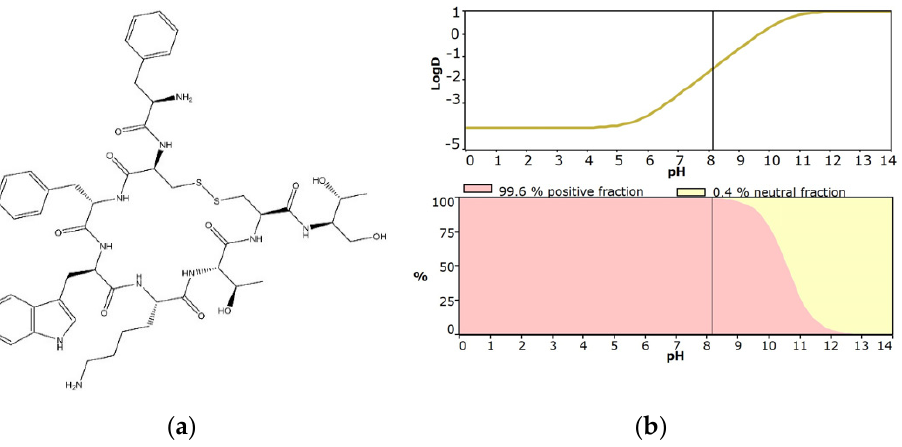
Figure 1. (a) Octreotide chemical structure; (b) plots of the LogD values (top) and the ionization Figure 1. ( a ) Octreotide chemical structure; ( b ) plots of the LogD values (top) and the ionization fraction (bottom) as a function of pH. fraction (bottom) as a function of